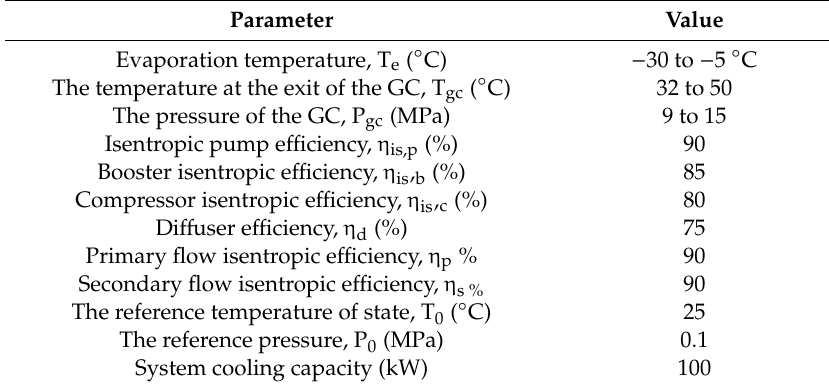
Table 1. The reference parameters and operating conditions of the cycle’s performance analysis. Parameter Value Evaporation temperature, T e ( ◦ C) − 30 to − 5 ◦ C The temperature at the exit of the GC, T gc ( ◦ C) 32 to 50 The pressure of the GC, P gc (MPa) 9 to 15 Isentropic pump e ffi ciency, η is,p (%) 90 Booster isentropic e ffi ciency, η is , b (%) 85 Compressor isentropic e ffi ciency, η is , c (%)